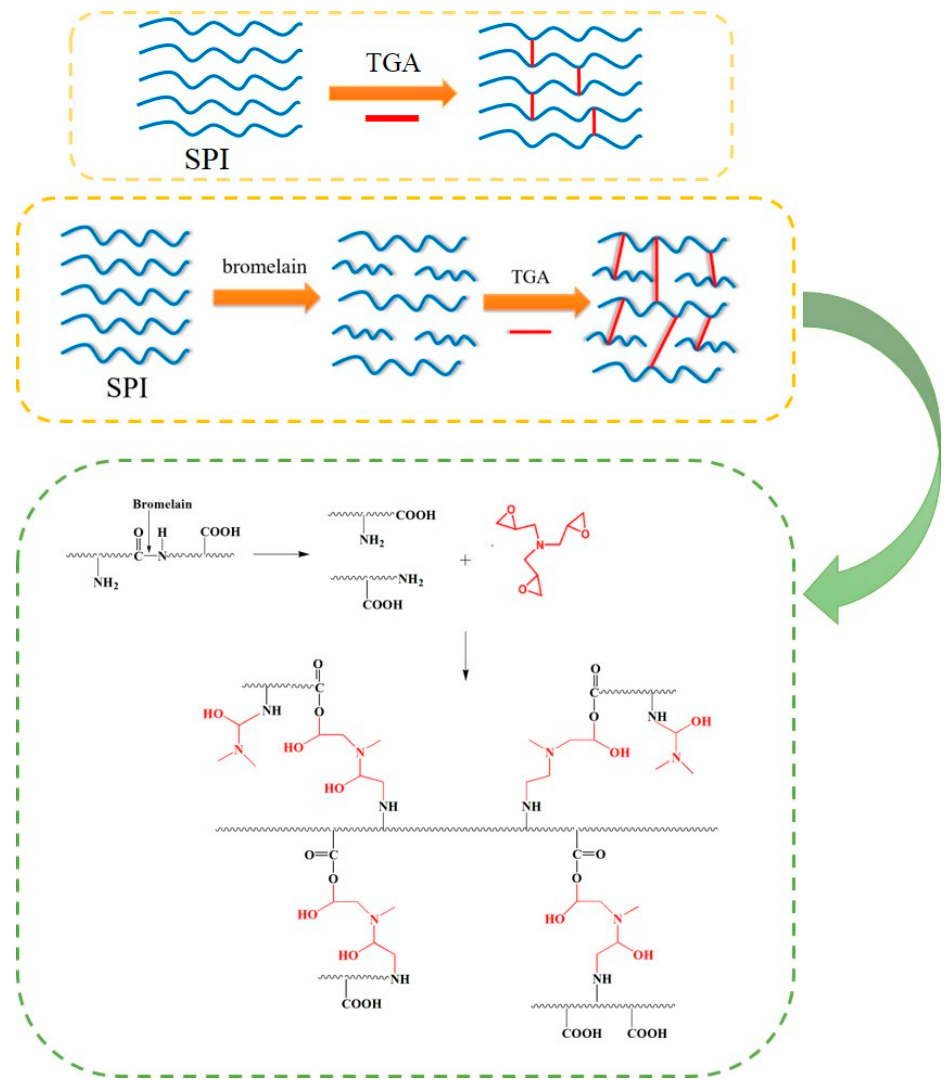
Figure 4. Cross-linking network of the soy protein adhesive.